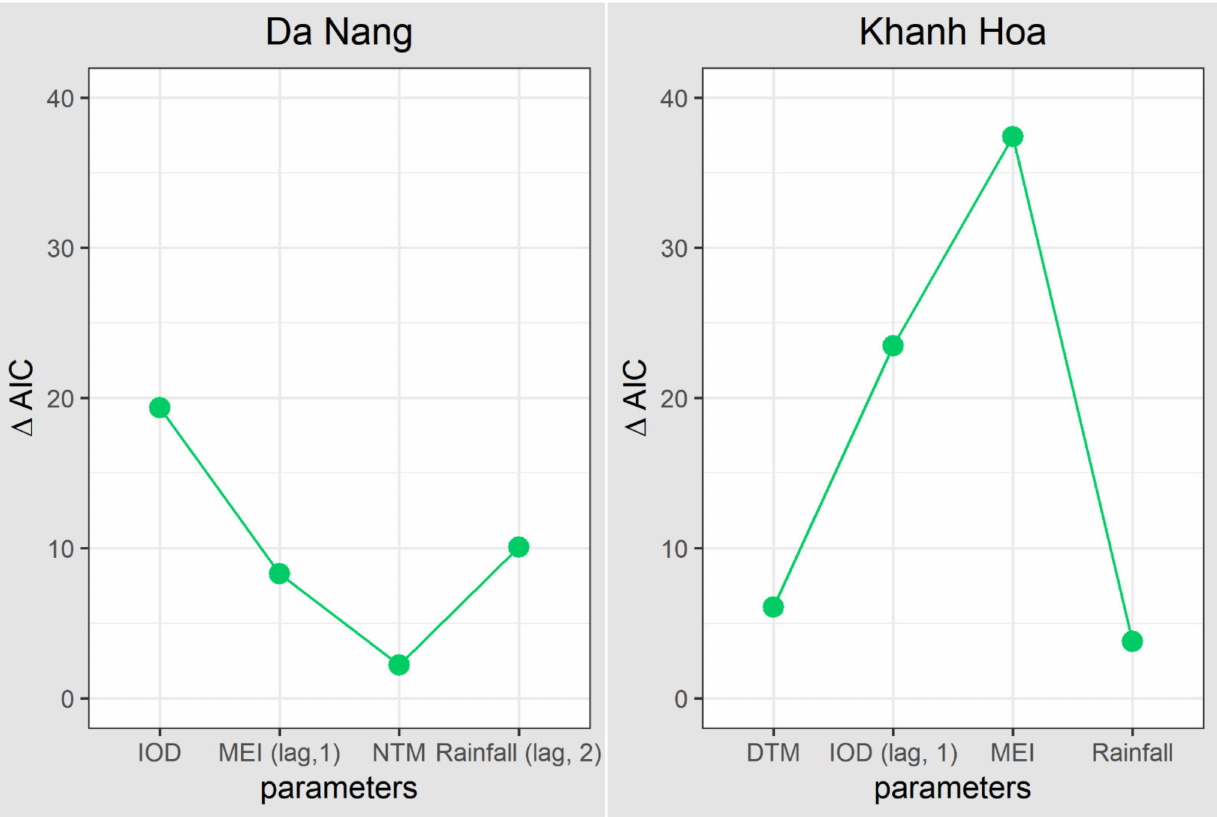
Figure 5. Importance of model parameters (Table 2) in Da Nang and Khanh Hoa. IOD—Indian Ocean Dipole; MEI—multivariate ENSO index; DTM—daytime temperature; NTM—nighttime temperature; AIC—Akaike information